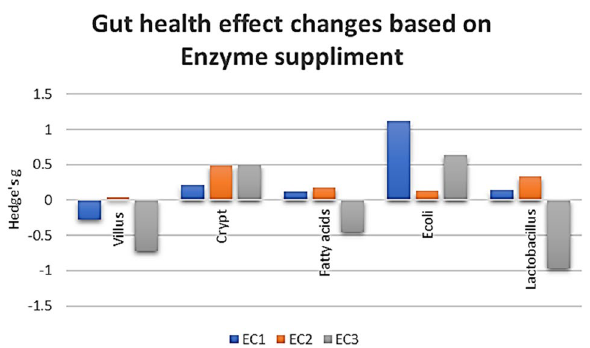
Figure 6. Gut health parameters assessment based on number of enzyme supplement: EC1: single enzyme; EC2: two enzyme complexes; EC3: three or more